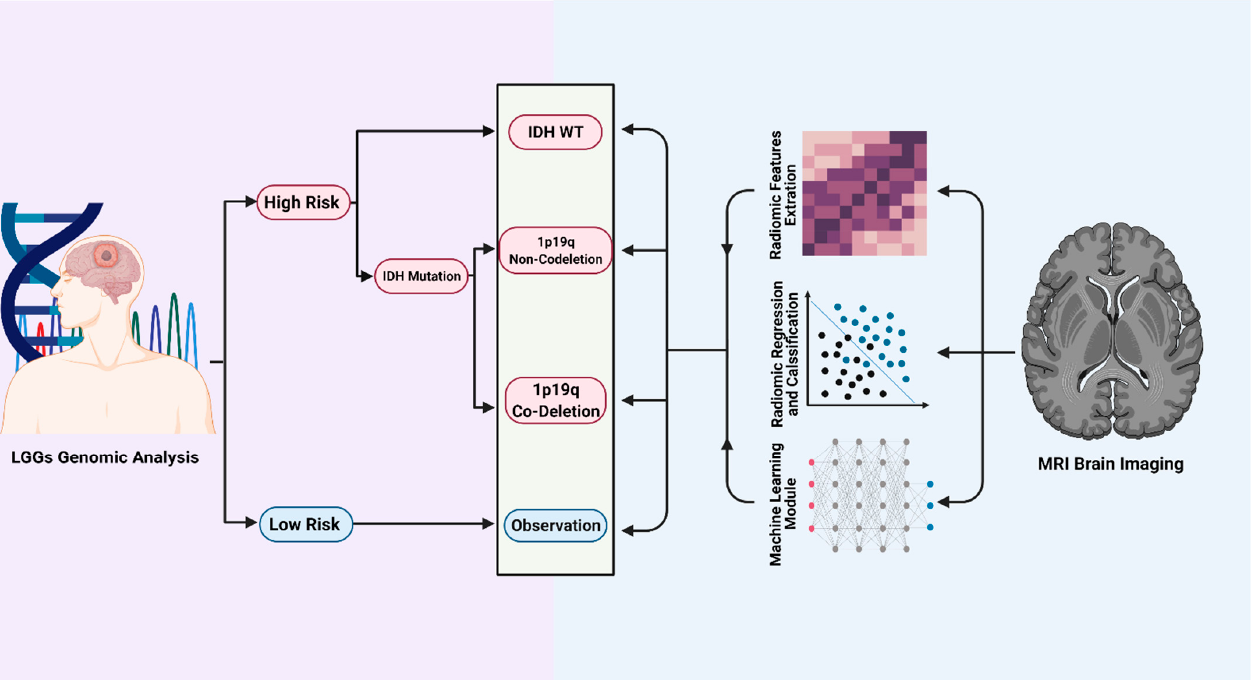
Figure 2. Using radiomics as a tool to predict the molecular landscape of LGGs. A graphic representation showing how radiomics and machine learning can be incorporated into the clinical setting to predict and classify patients with low-grade gliomas into high risk vs. low risk groups based on IDH and 1p19q co-deletion status. The current data available support radiomics as a robust reliable tool that can non-invasively classify those patients by extracting radiomics features from MRI brain scans. Created with BioRender.com.